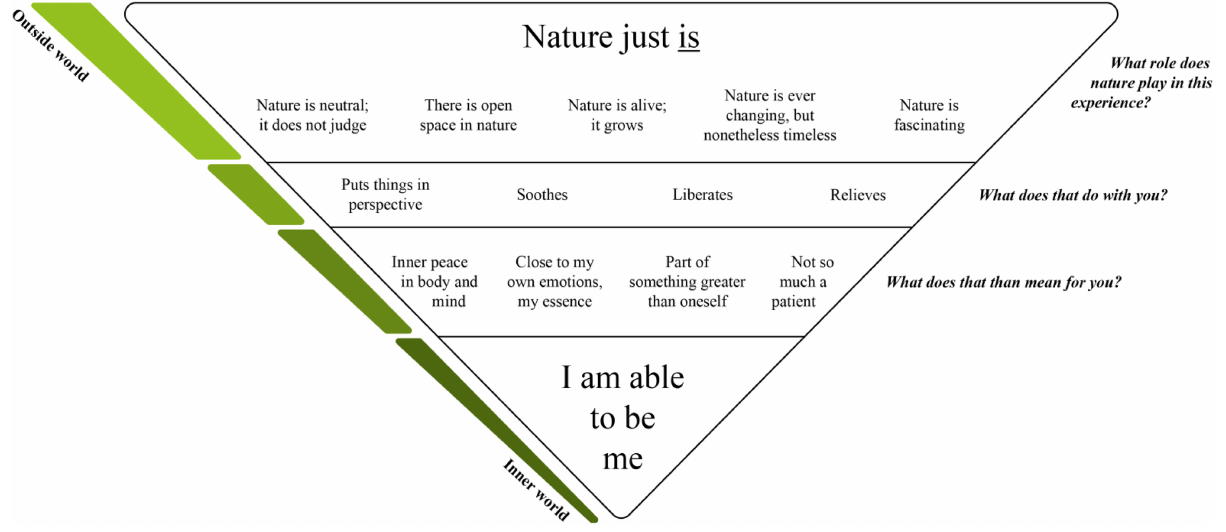
FIGURE 1 | Conceptual model of experiences regarding nature during